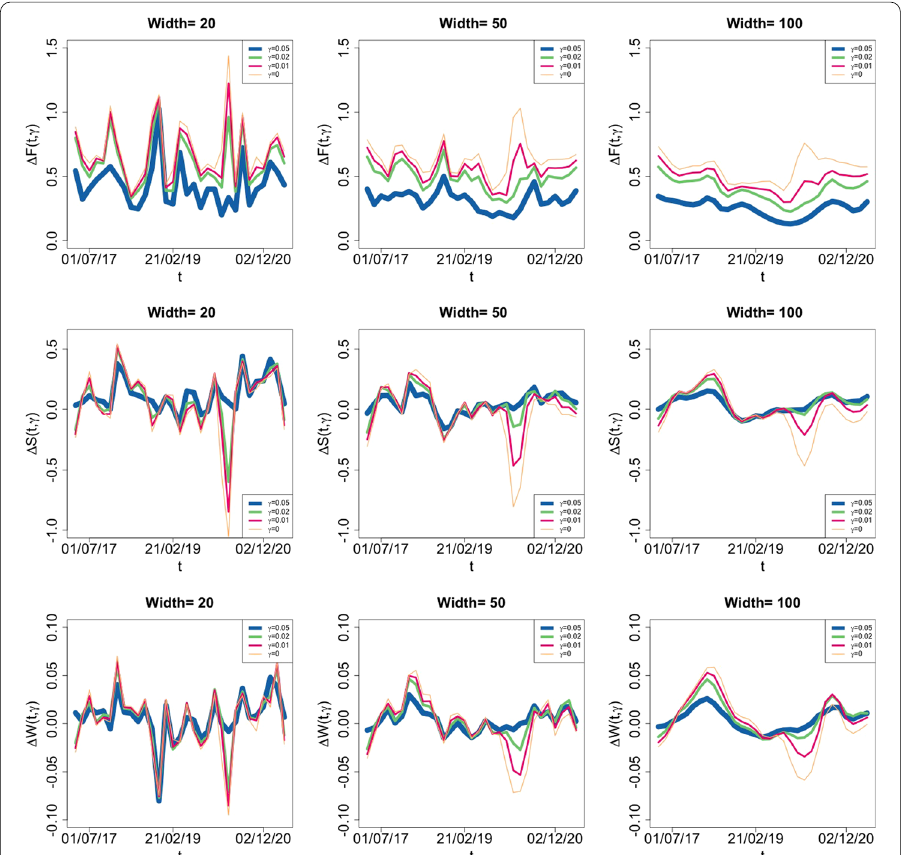
Fig. 11 The plots show the dynamics of the measures defined in “Results” section. Each panel corresponds to a bandwidth h , in particular h = 20,50,100 from left to right respectively. Each line in the plot corresponds to a measure, as reported on